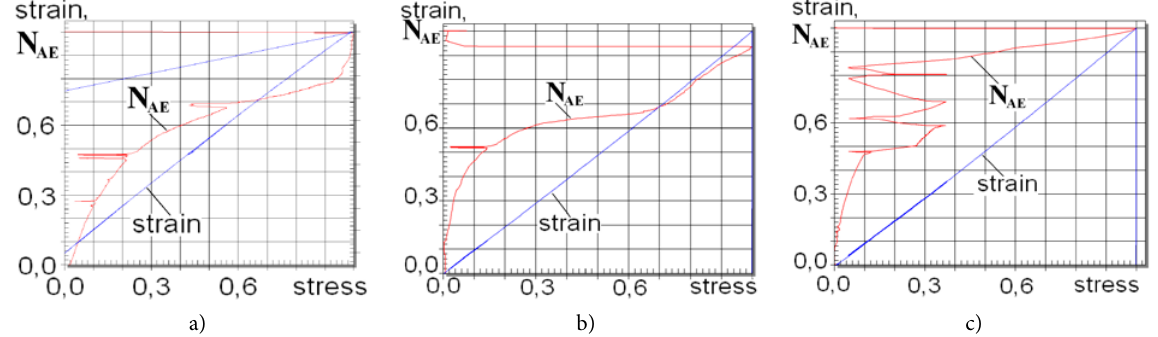
Fig. 9. Dependence of the total AE and the deformation on the stress-strain of a sample with longitudinal fibers: a – with a triple training of 20% of the breaking load (sample width: 20 mm); b – with a six-time training of 15% of the breaking load (sample width: 30 mm); c – with a triple training of 38% of the breaking load (sample width: 30 mm)